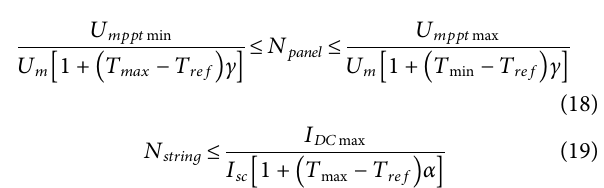
FIGURE 8 | Six typical con fi gurations for LPPs. (A) PV1. (B) PV2. (C) PV3 – PV5. (D)